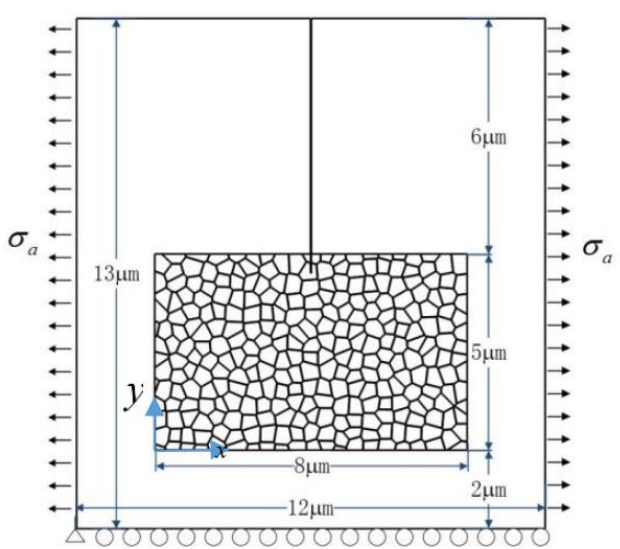
Figure 6. The polycrystal model under tensile load.